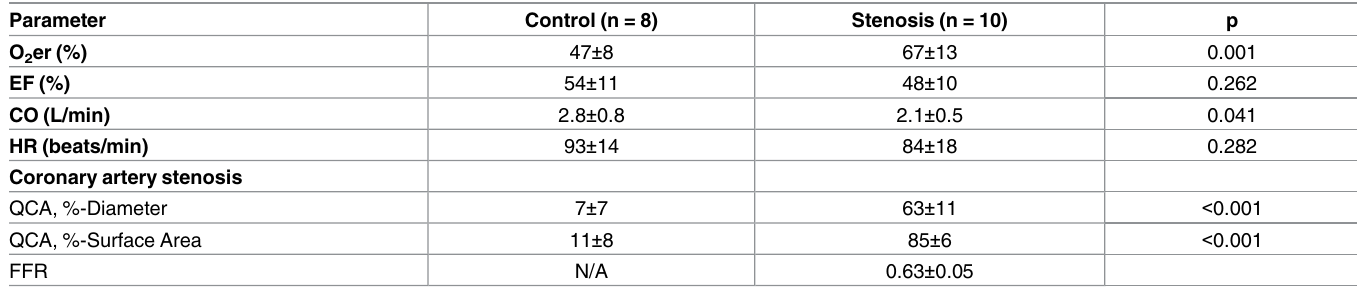
Table 1. Baseline Function and